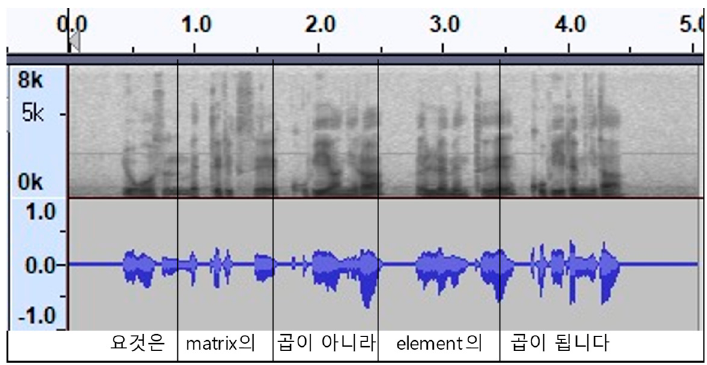
Figure 1. An application of the proposed method: English–Korean automatic speech translator.